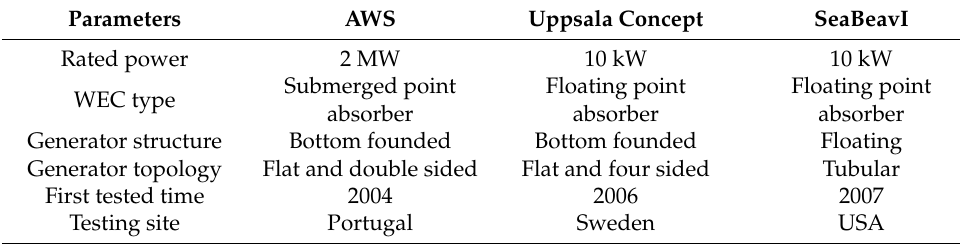
Table 1. WECs applying the linear generator tested in the oceanic environment.